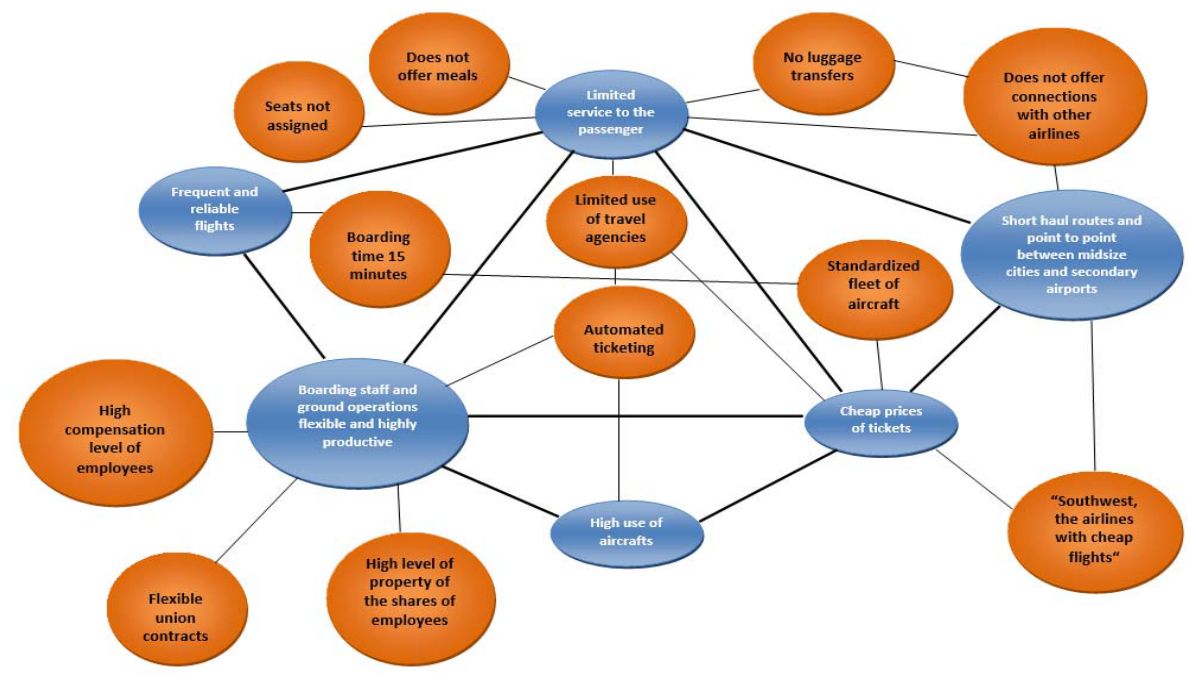
Fig. 3. System of activities of Southwest Airlines